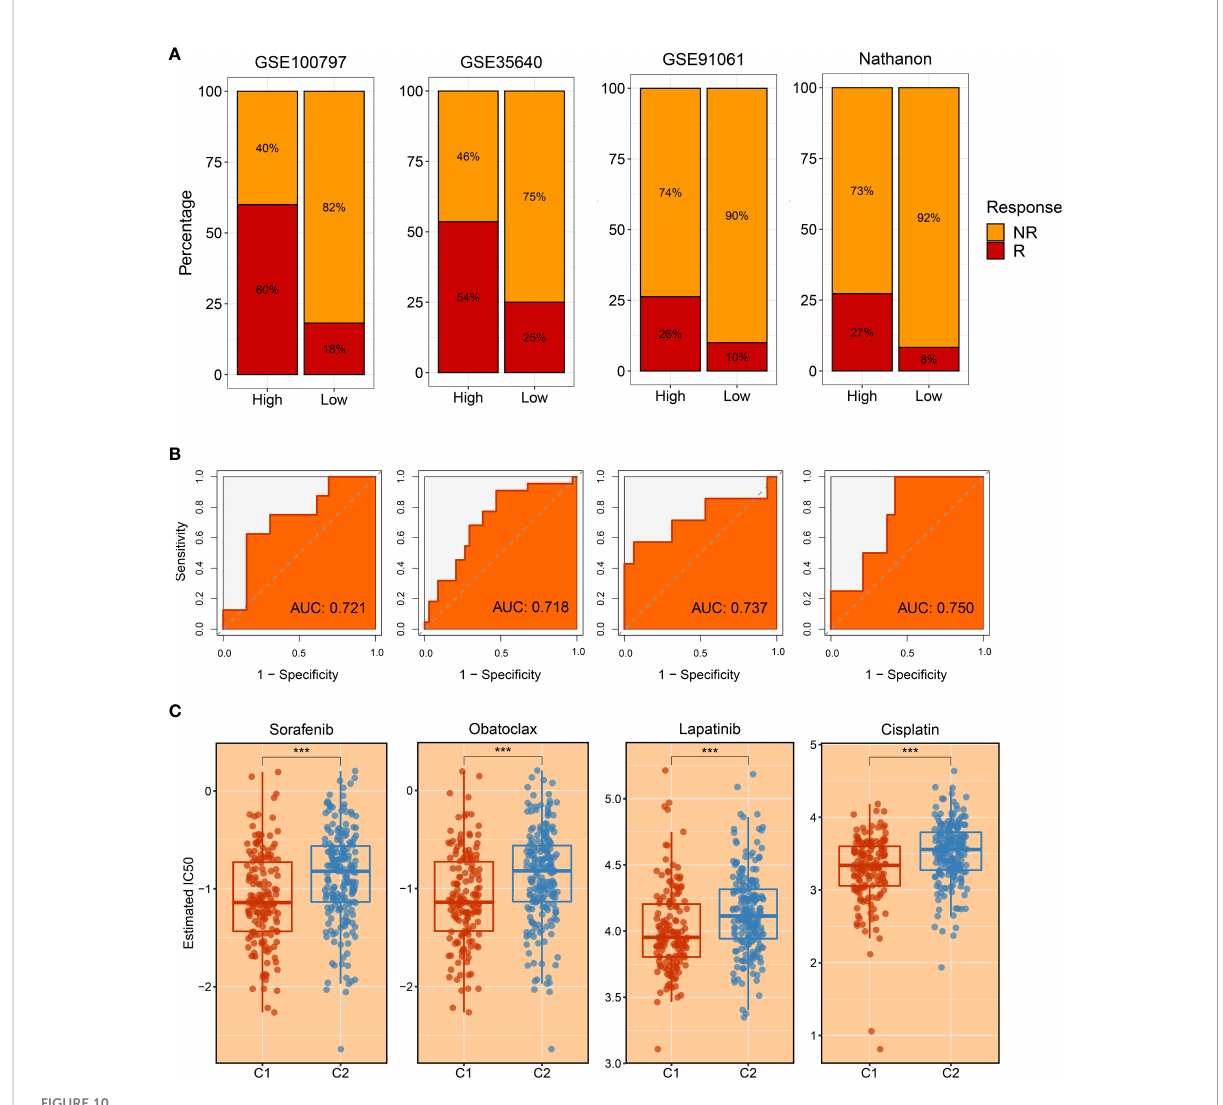
FIGURE 10 The evaluation of immunotherapy and drug-associated treatment. (A) The immunotherapy response ratio of risk scores measured by characteristic genes in GSE100797, GSE35640, GSE91061, and Nathnaon datasets. (B) Receiver operating characteristic (ROC) curves of risk scores to predict the bene fi ts of immunotherapy in GSE100797, GSE35640, GSE91061, and Nathnaon datasets. (C) The promising therapeutic agents for patients in C1. ***p <